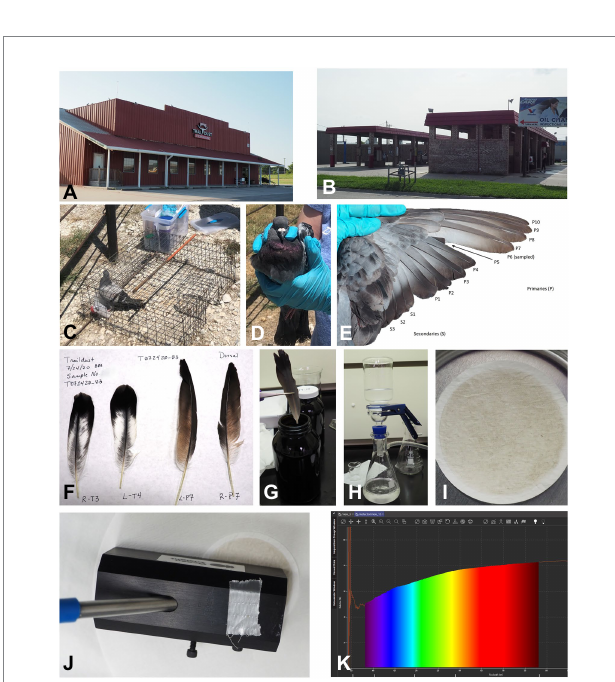
FIGURE 2 Field sampling and laboratory methods used to investigate the spectral properties of PM collected from Rock Pigeon feathers in Denton County, Texas. (A) Rural site, (B) Urban site, (C) A pigeon in a trap at the rural location, (D) Rural pigeon, (E) Molting pattern in the right wing of a Rock Pigeon, (F) Pooled feather sample labeled and ready for surface area determination, (G) Sonication of a feather sample, (H) Sample filtration, (I) Dried filter with collected particulates, (J) Measurement of diffuse reflectance, and (K) Sample spectral